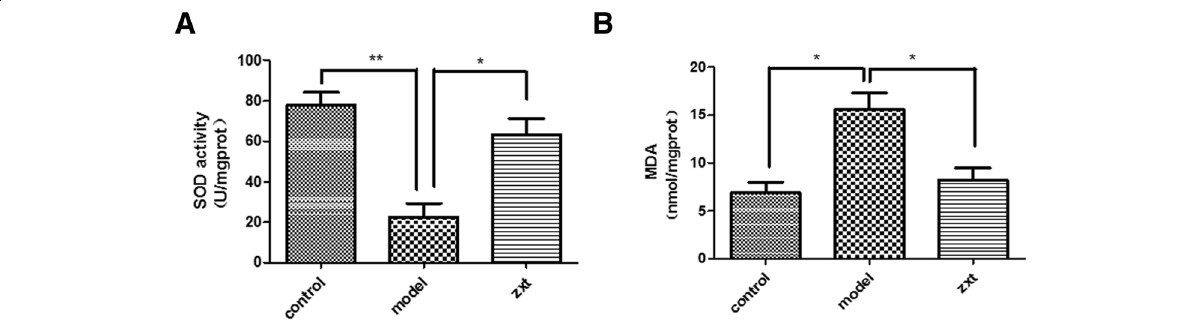
Fig. 3 The Alisma and Rhizoma decoction reduces oxidative stress in MCD-induced NASH. Mice were treated as detailed in Fig. 2. The SOD